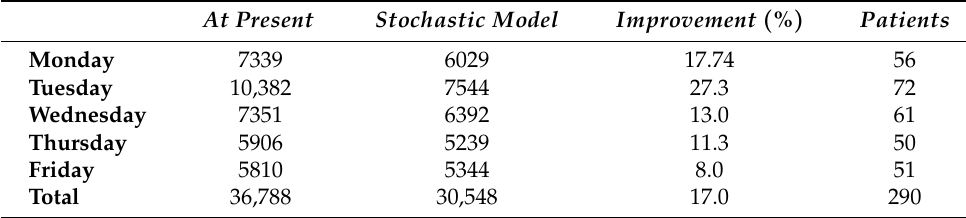
Table 6. Waiting minutes provided by the stochastic model and with actual procedure. At Present